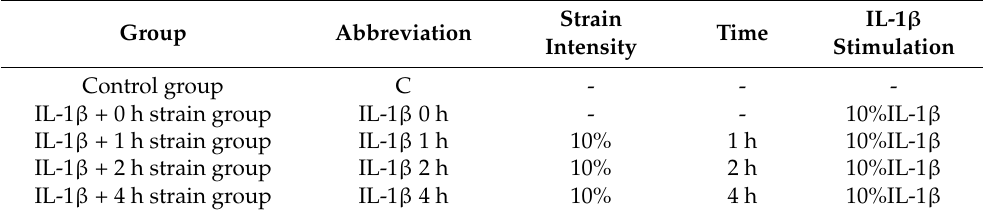
Table 4. Mechanical straining